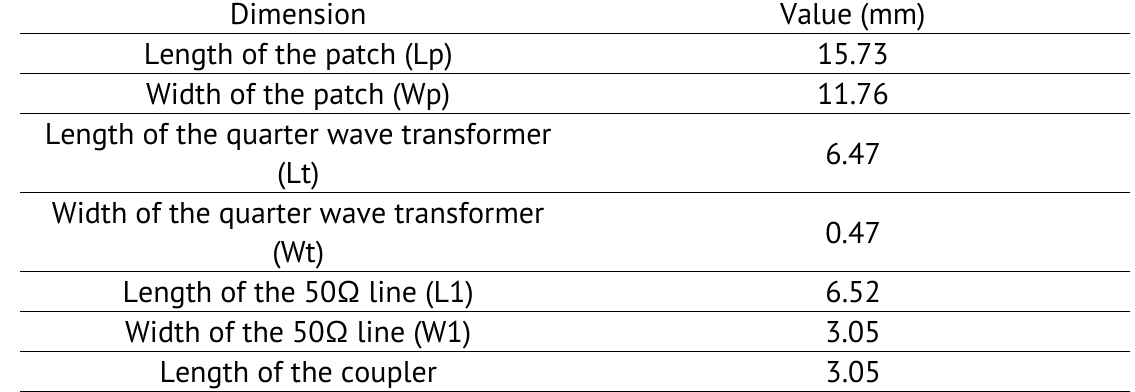
Dimensions and values of conventional microstrip antenna